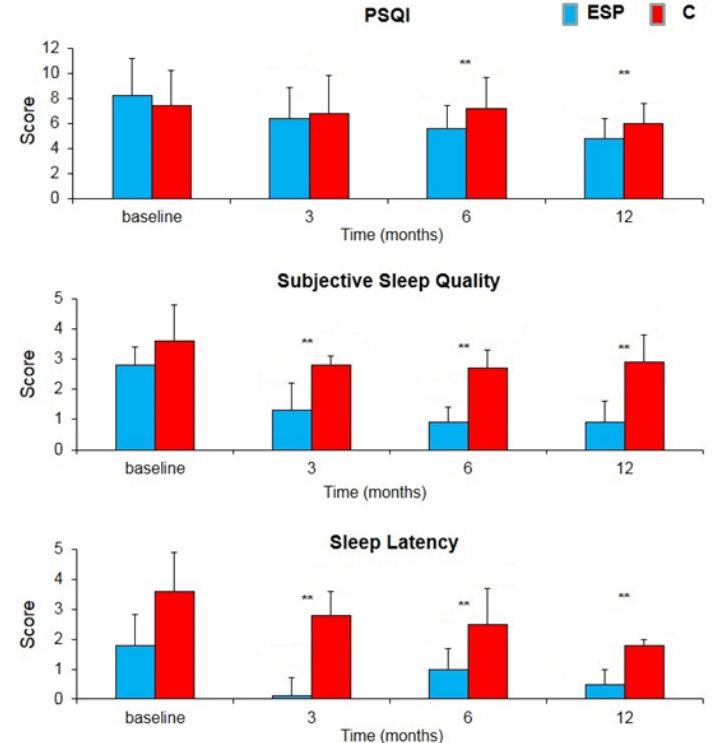
Figure 2. Changes in severity score of The Pittsburgh Sleep Quality Index (PSQI), subjective sleep quality and sleep latency during the treatment with soy isoflavones + lactobacilli + magnolia + agnus castus (ESP) or isoflavones alone (C). Data is expressed as mean ± SE. ** p < 0.01 vs. baseline.